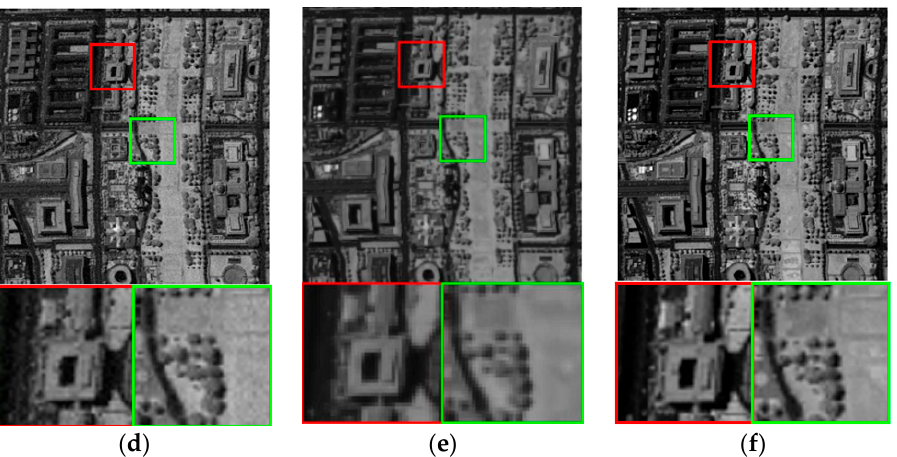
Figure 6. Visual comparison on band 72 of Washington dataset: ( a ) Clean / noise-free image band, ( b ) Noisy band, ( c ) Restoration result from VBM3D, ( d ) Restoration result from Godec, ( e ) Restoration result from SLrank, ( f ) Restoration result from the proposed method. Table 1. Average peak signal-to-noise ratio (PSNR) and structure similarity (SSIM)for different restoration methods